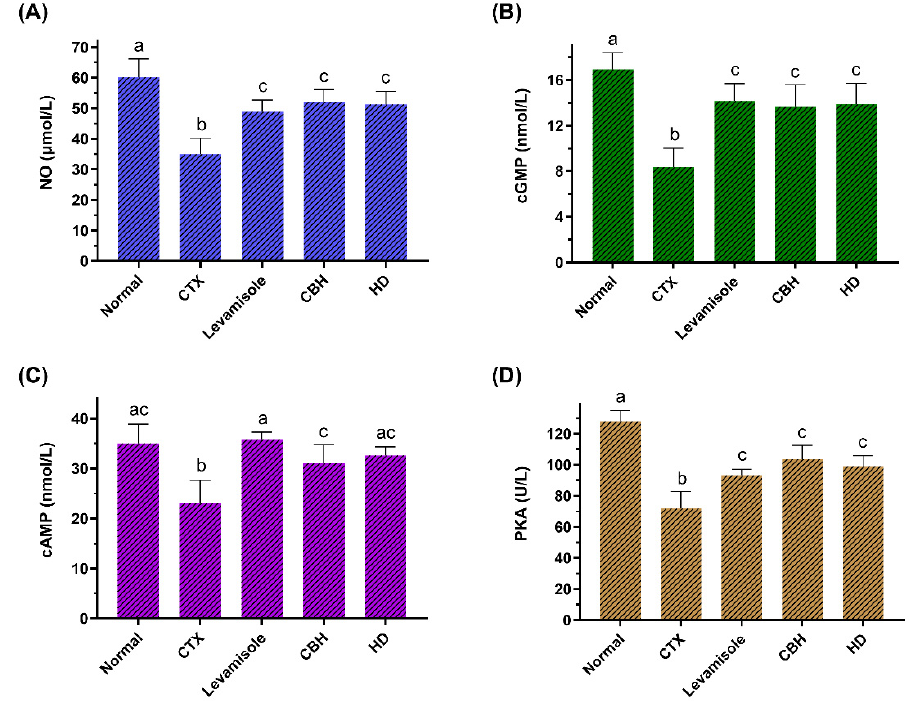
Figure 5. The effect of CHB and HD on the NO ( A ), cGMP ( B ), and cAMP ( C ) content, as well as the PKA ( D ) activity in the splenocytes of CTX-treated mice. Data are presented as means ± SD ( n = 10). Different letters for the same index among the groups represent significant differences at p < 0.05.